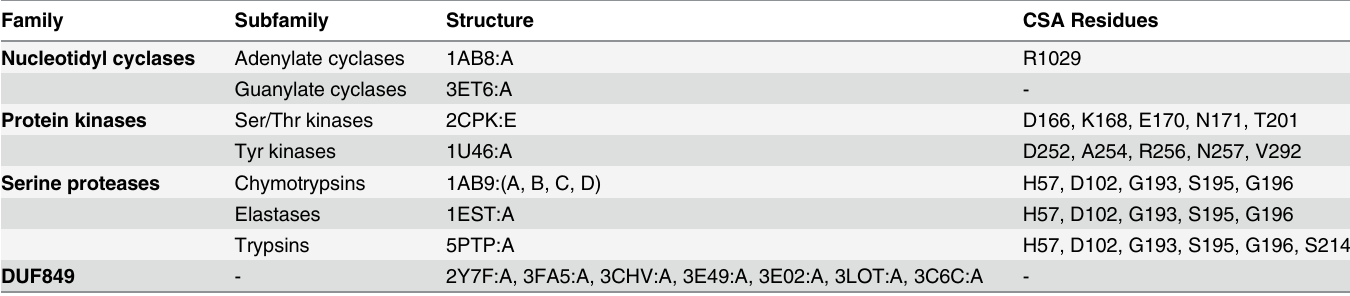
Table 2. Structures used as templates for modeling the family